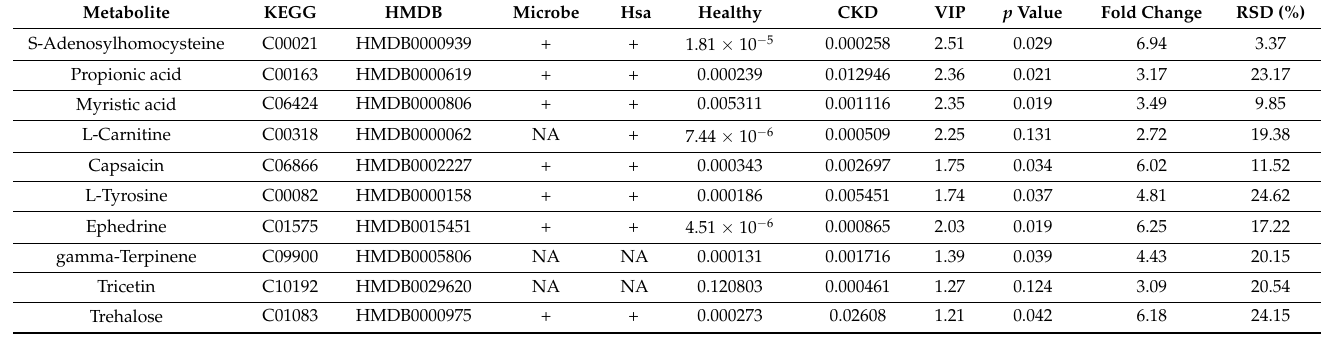
Table 3. Summary statistics of top 10 discriminating metabolites in feces samples.